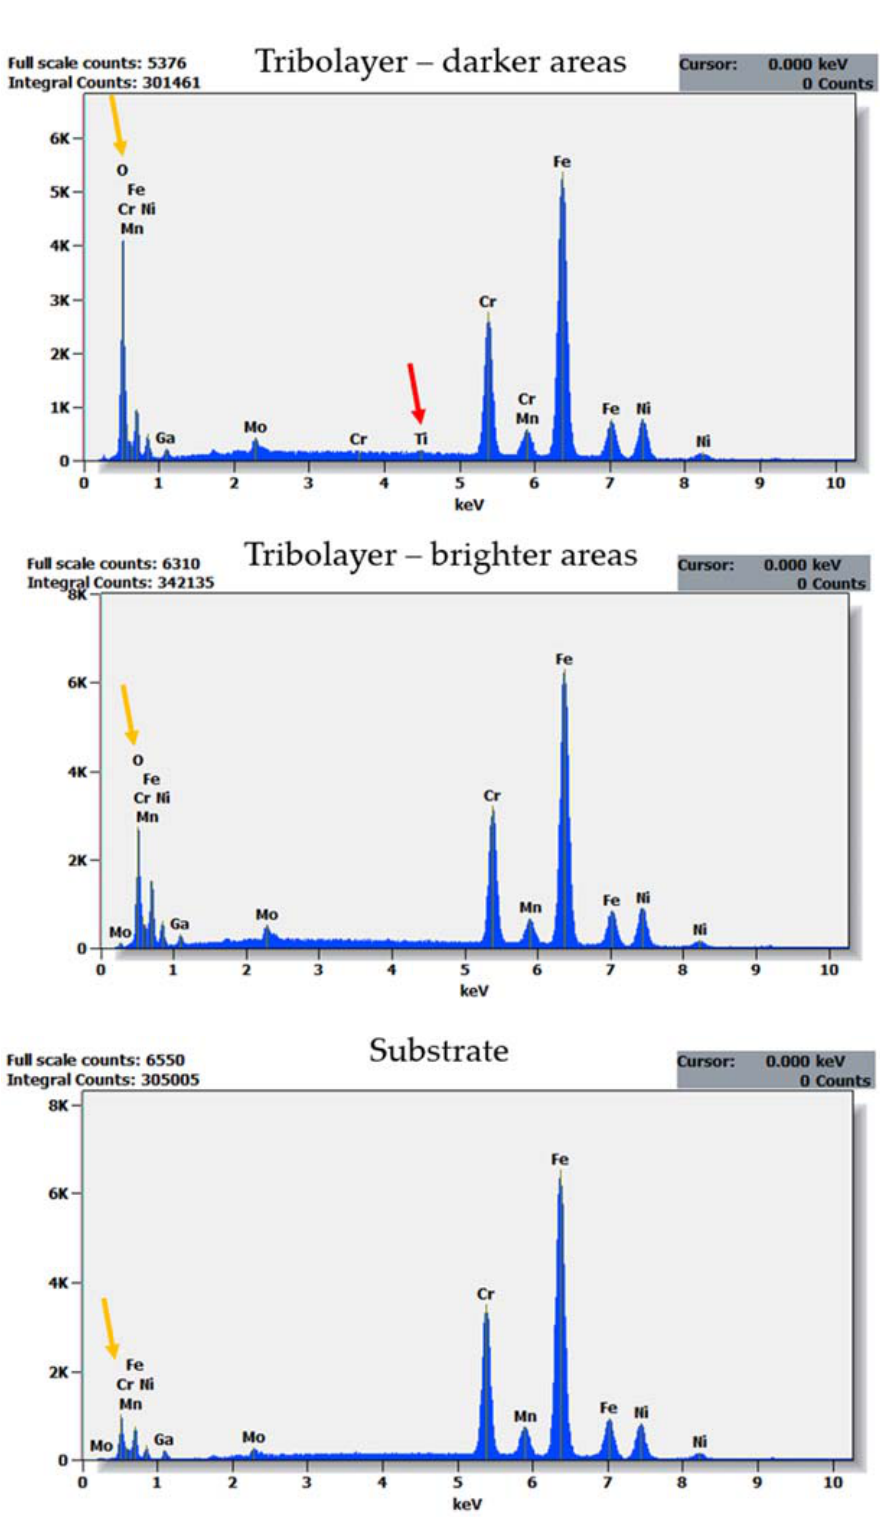
Figure 11. EDX spectra collected for a cross-section of the wear track obtained on the TiN-coated 316L stainless steel. The cross-section was obtained with the use of FIB. Therefore, Ga and Pt can be present in spectra. Note the oxygen lacking in spectrum obtained for the substrate material (yellow arrow), as well as very small amounts of Ti seen only in frictional layer (red